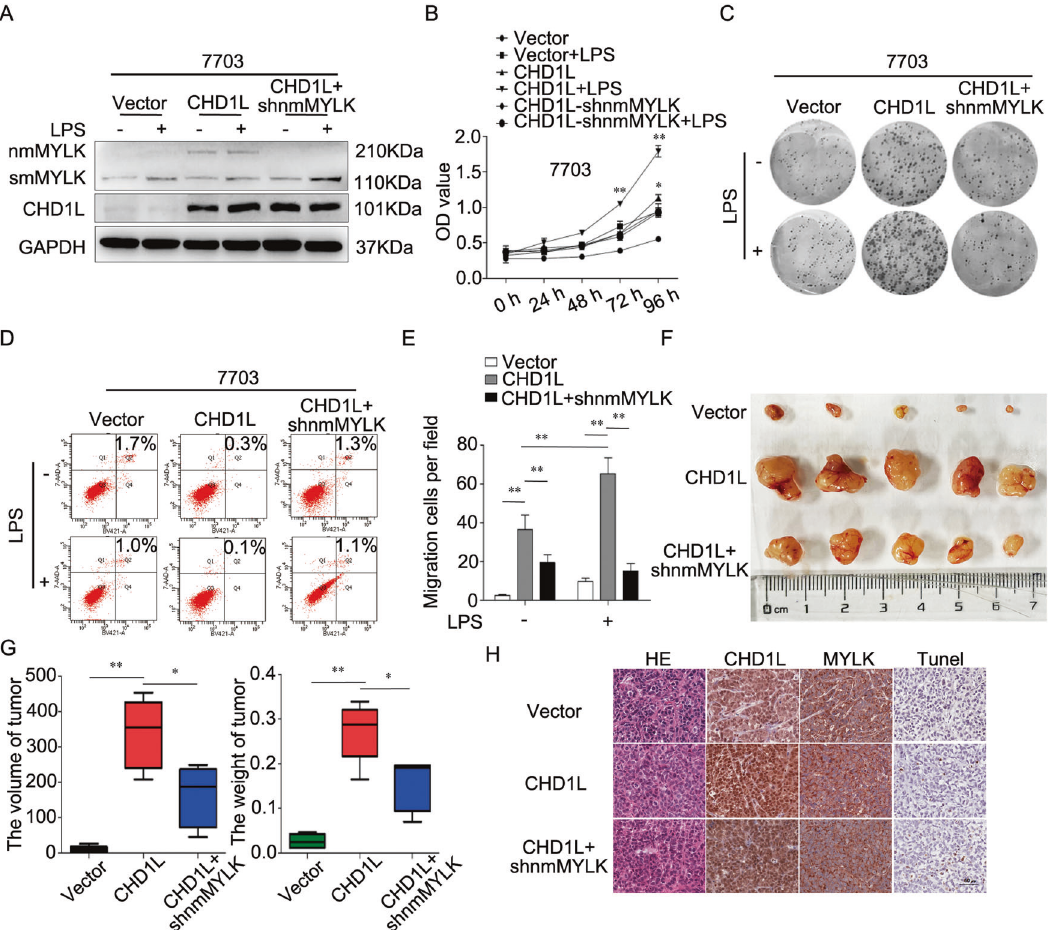
Fig. 4 nmMYLK is essential for CHD1L-promoted malignant proliferation in tumor cells. A – H 7703 overexpression CHD1L cells were infected with speci fi c shRNA (shnmMYLK) lentivirus. Western blot was applied to detect the expression of CHD1L and MYLK ( A ). Cell proliferation ability was examined using MTS assay ( B ) and Colony formation assay ( C ). Cell apoptosis level was examined using fl ow cytometry analysis ( D ). Cell migration ability was examined using Transwell test ( E ). 7703-CHD1L cells infected with shnmMYLK lentiviruses and inoculated subcutaneously into nude mice, following by monitoring for tumor growth, Tumor pictures ( F ), Tumor volumes and weight ( G ). Tumor tissues were embedded with paraf fi n and subjected to H&E and immunohistochemistry analysis (20×), Scale bar = 50 μ m, representative images were presented ( H ). Data were performed by mean with SD from three independent experiments. * P < 0.05, ** P <